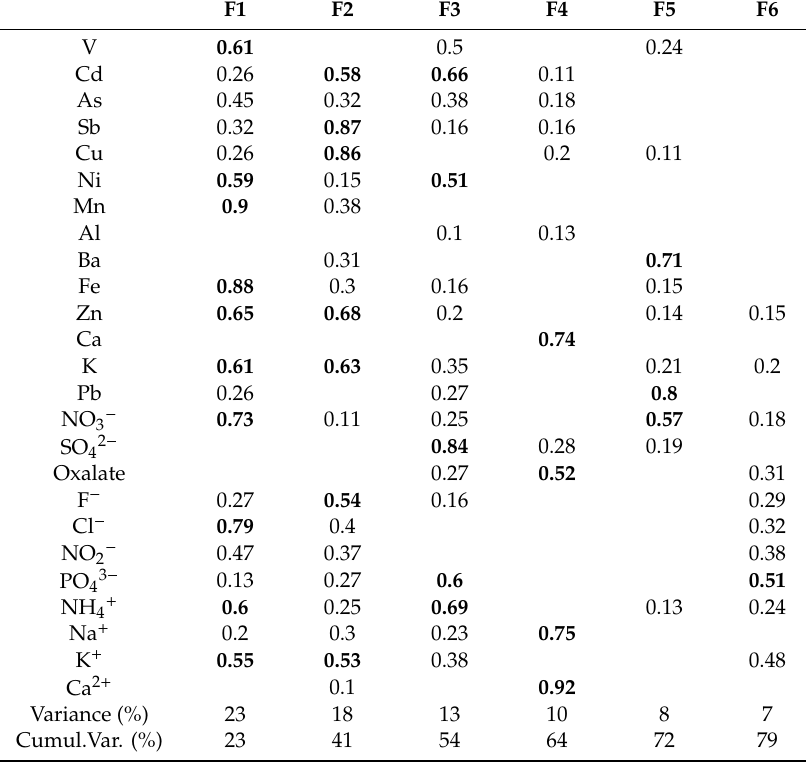
Table 7. Principal component analysis results of PM 1 components in